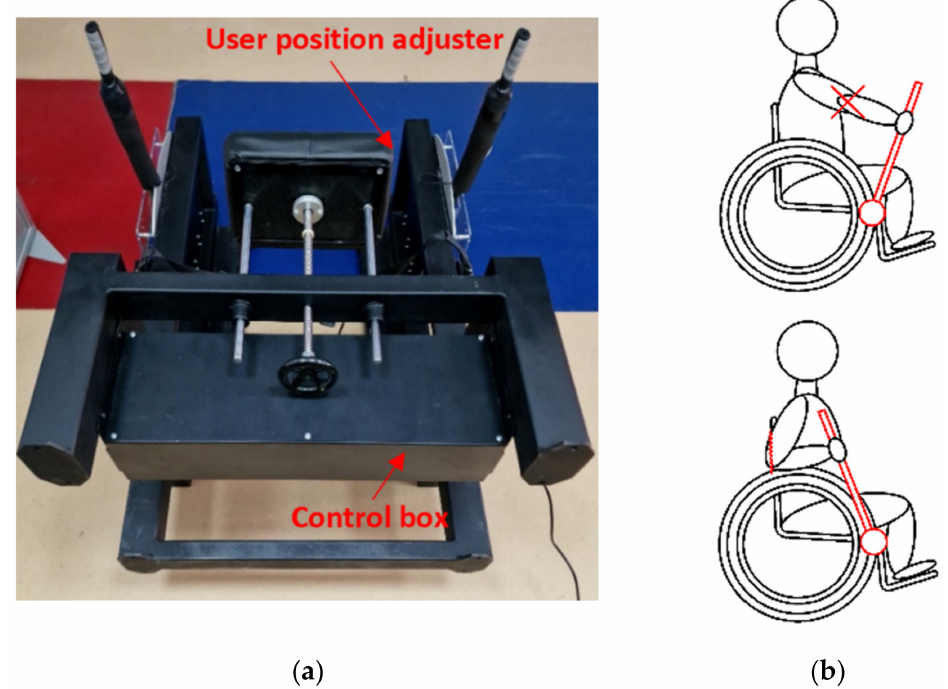
Figure 3. ( a ) Rear view of the device; ( b ) proper positioning of the user, ensuring a safe and ergonomic position during